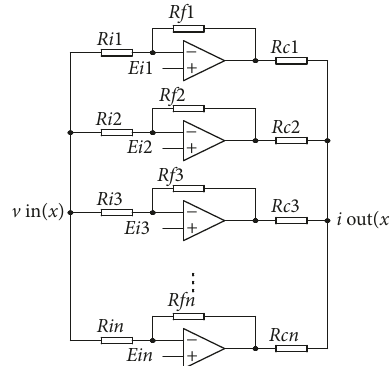
Figure 3: Realization of SNLFs using OpAmps represented in Figure 4 as PWL block.